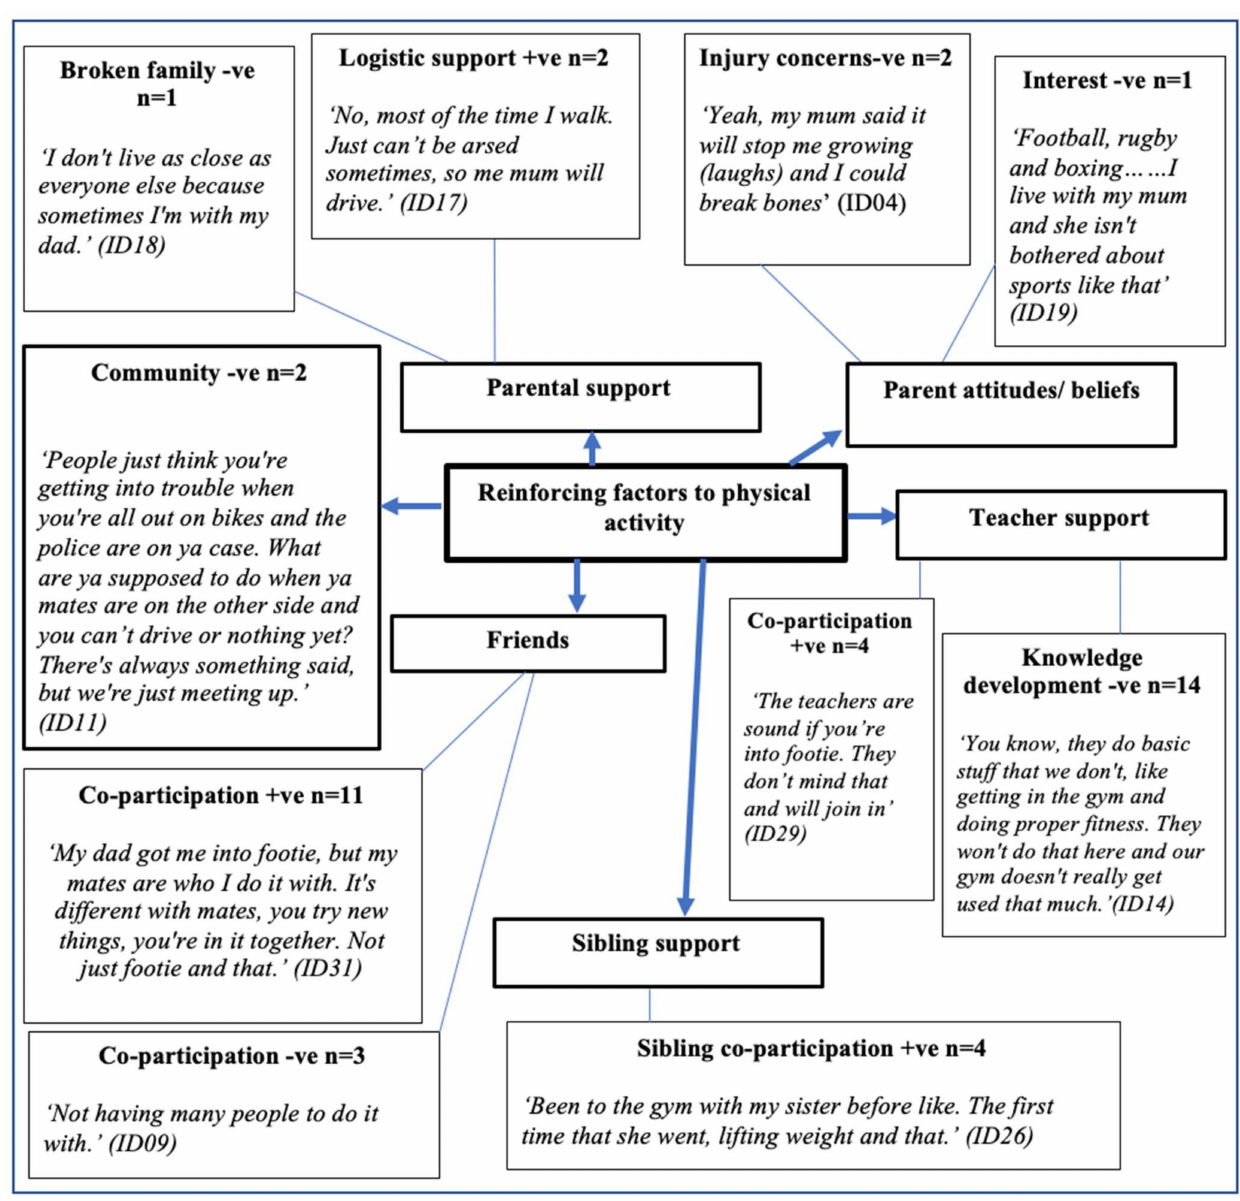
Figure 3. Reinforcing factors to physical activity. +ve = positive; − ve =